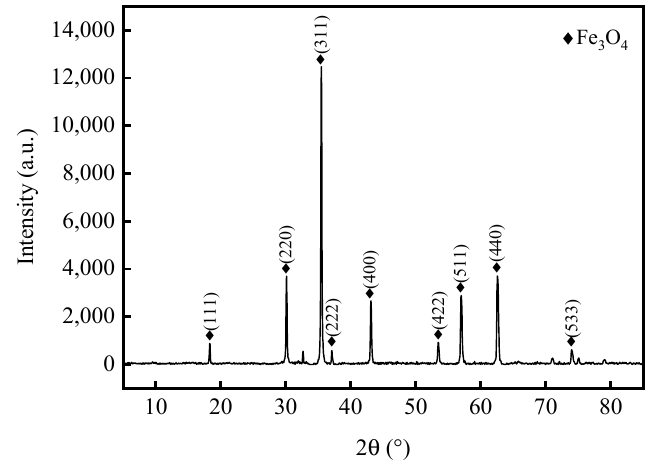
Figure 10. The XRD pattern of Fe 3 O 4 .